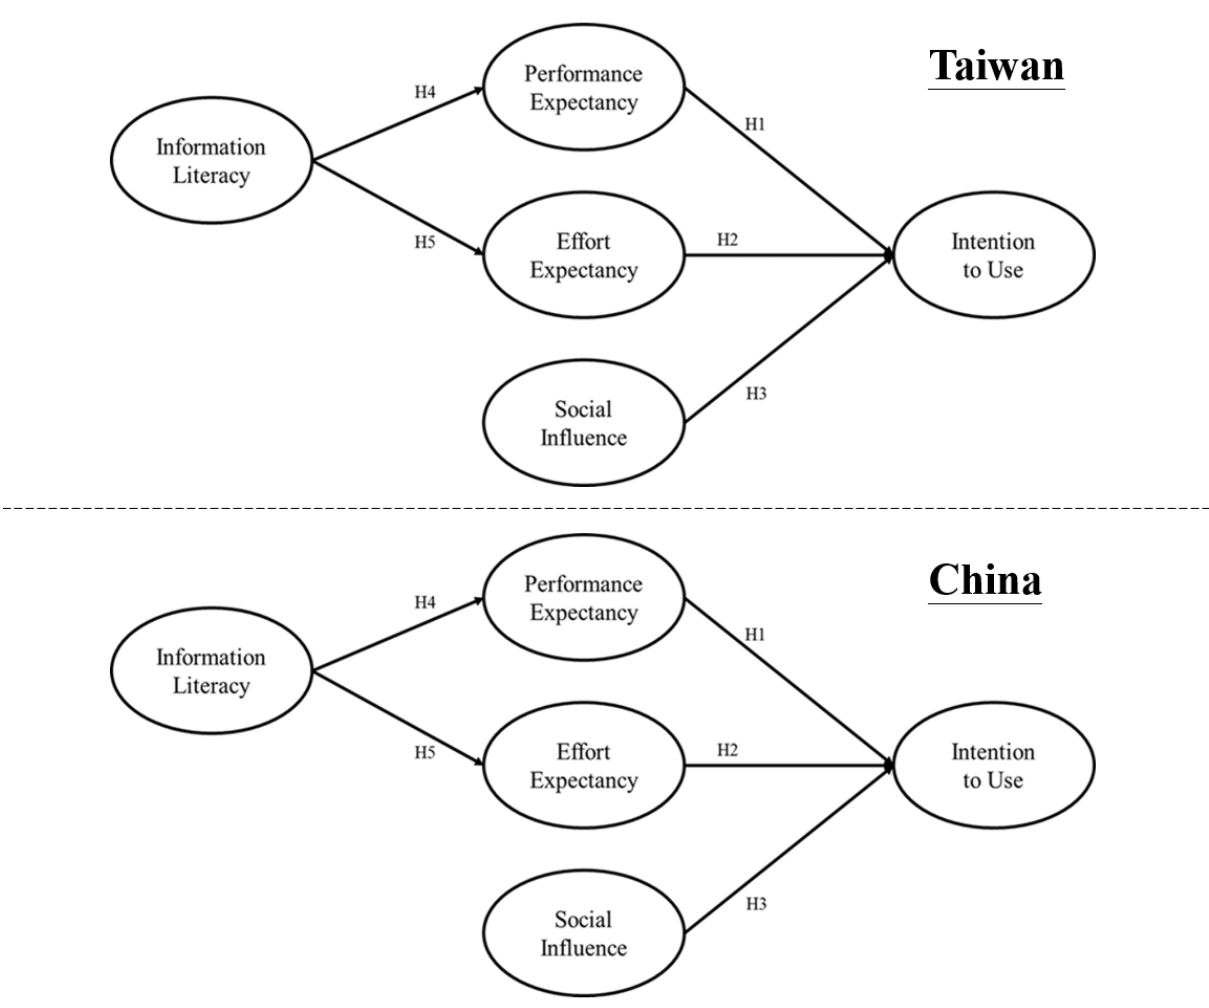
Figure 1. Research